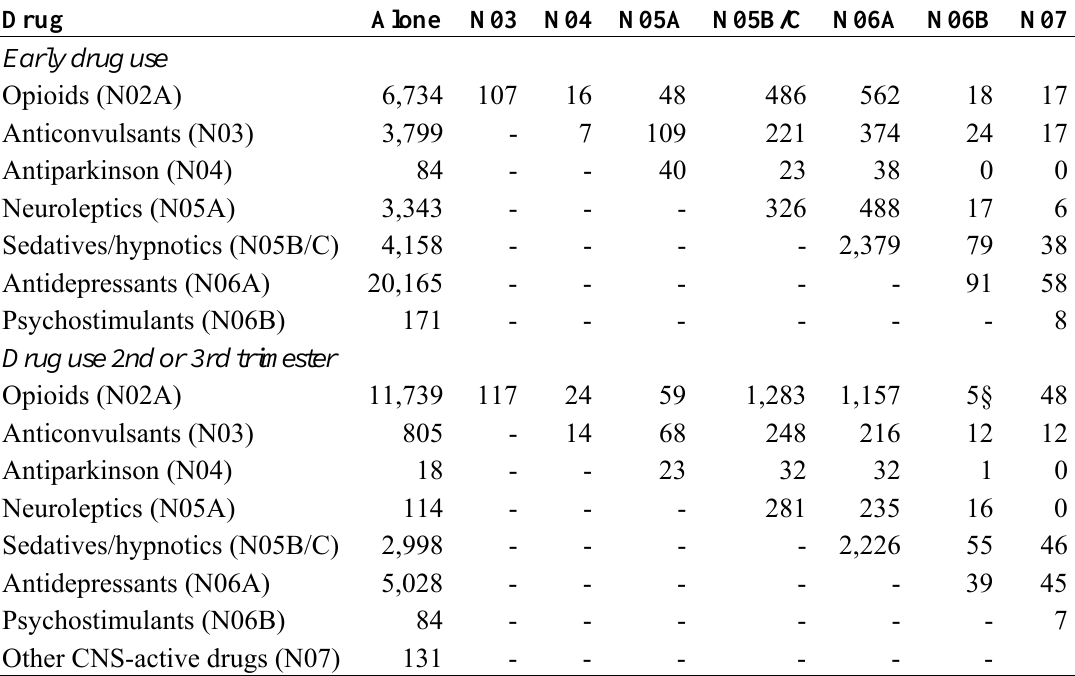
Table 41. Cross-tabulation of CNS active drugs: number of infants exposed in early pregnancy or born by women who filled prescriptions for two or more CNS active drugs during the 2nd or 3rd trimester. Neuroleptics exclude dixyrazine and prochlorperazine. The first column gives the explanation to the column ATC